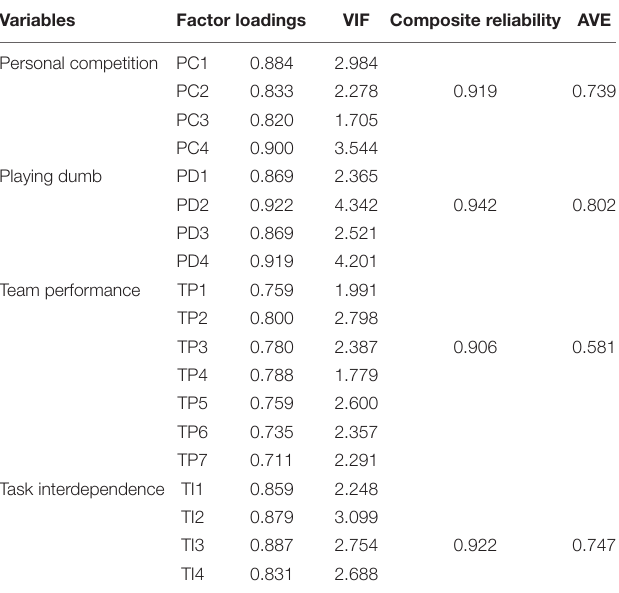
TABLE 9 | Measurement model (with moderation). TABLE 10 | Moderation effect.